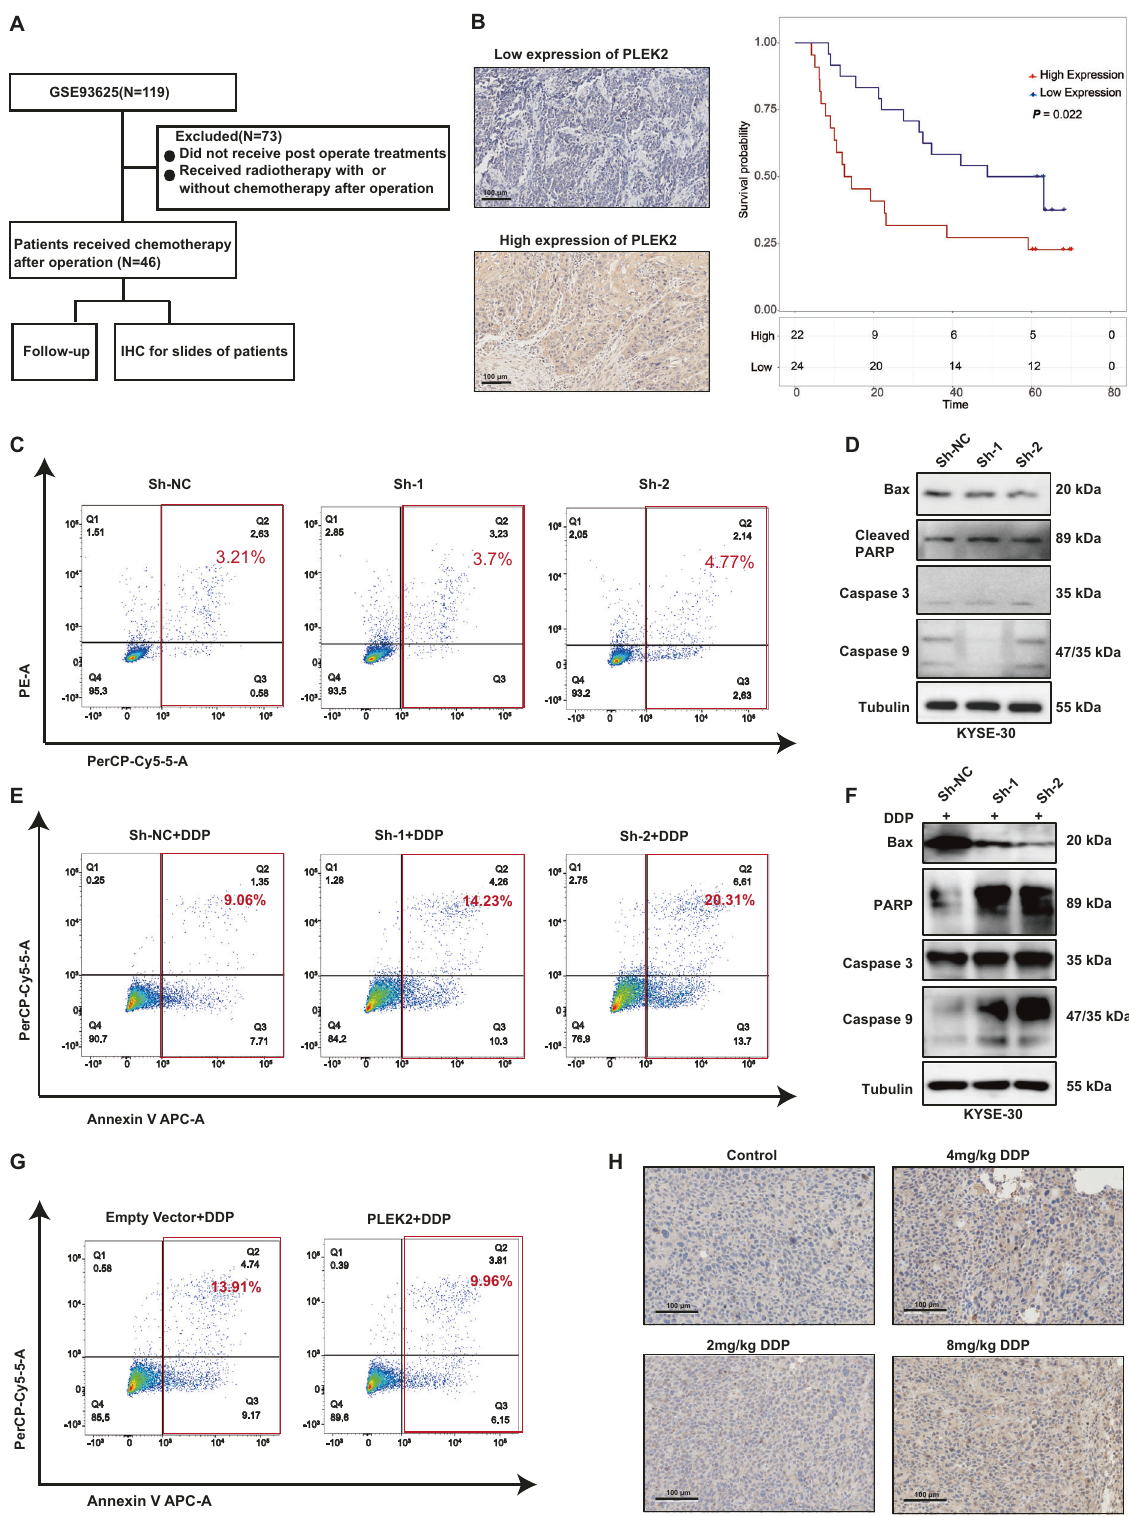
Fig. 4 PLEK2 linked to chemo-resistance of ESCC cell lines. A The scheme of process of choosing patients; B Representative images of high and low expression of PLEK2 (left) and Kaplan-Meier plots of OS of patients who received chemotherapy in the database GSE53625 (right); C The apoptosis rate of PLEK2 stably knockdown KYSE-30 cells; D Western blot analysis of markers of cell apoptosis including Bax, Cleaved PARP, Caspase 3 and Caspase 9. Tubulin was used as loading control; E The apoptosis rate of PLEK2 stably knockdown KYSE-30 cells after the treatment of DDP for 24 h; F Western blot analysis of markers of cell apoptosis; G The apoptosis rate of KYSE-30 with PLEK2 stably overexpressed after the treatment of DDP for 24 h; H Representative images of IHC in KYSE-30 xenograft tumours treated with varying dosage of